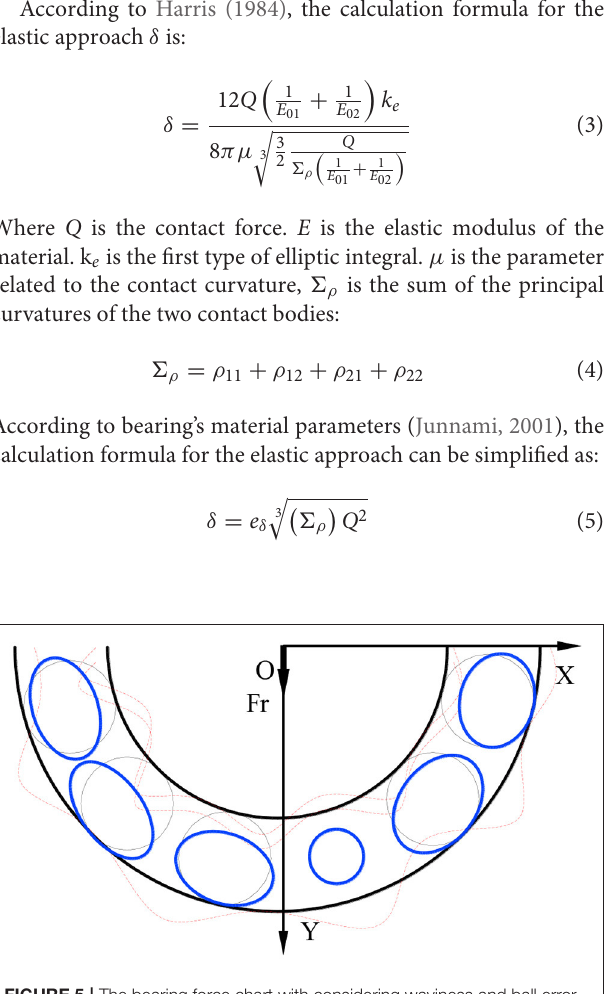
FIGURE 5 | The bearing force chart with considering waviness and ball